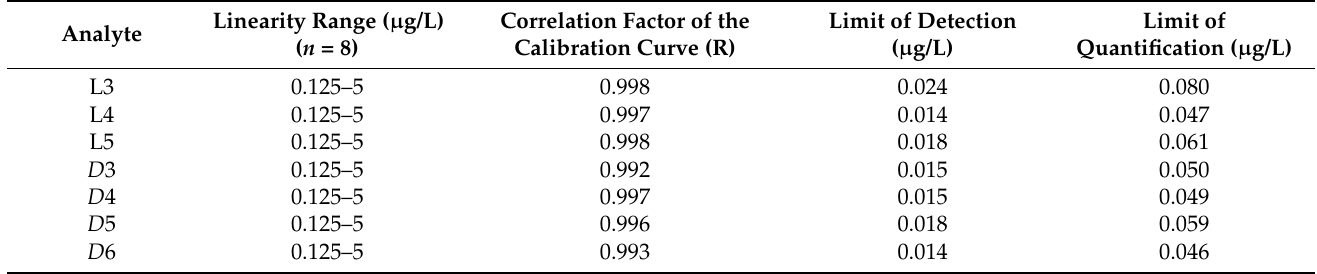
Table 3. Linearity range and limits of detection and quantification for VMSs analysis by HS-SPME/GC-FID. Analyte